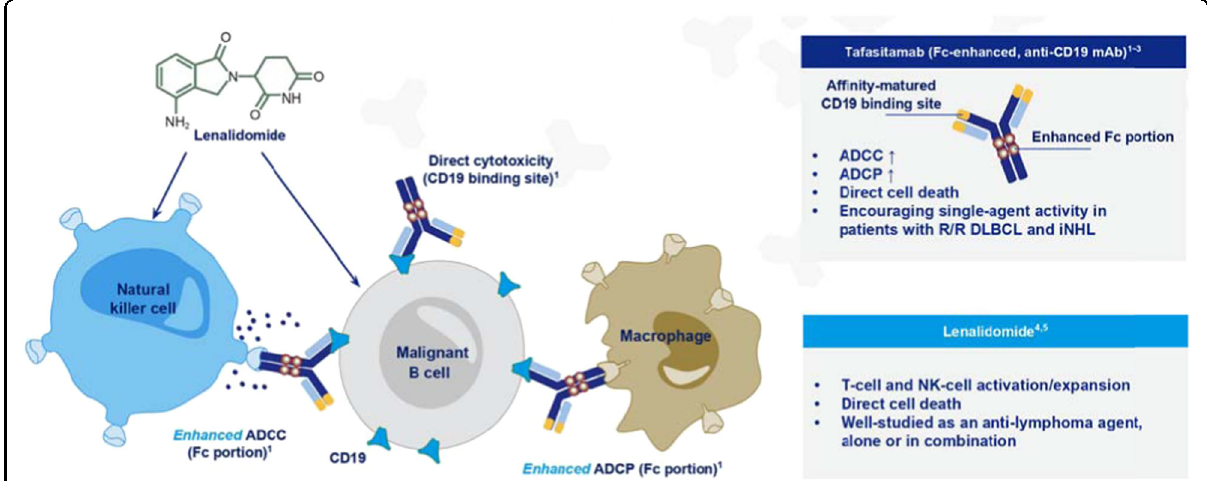
Fig. 1 Mechanism of action of tafasitamab and lenalidomide. Tafasitamab has been Fc enhanced to increase antibody-dependent cellular cytotoxicity (ADCC) which augments interactions with natural killer (NK) cells activated and expanded by lenalidomide, antibody-dependent cellular phagocytosis (ADCP) to enhance interactions with macrophages, and direct cell